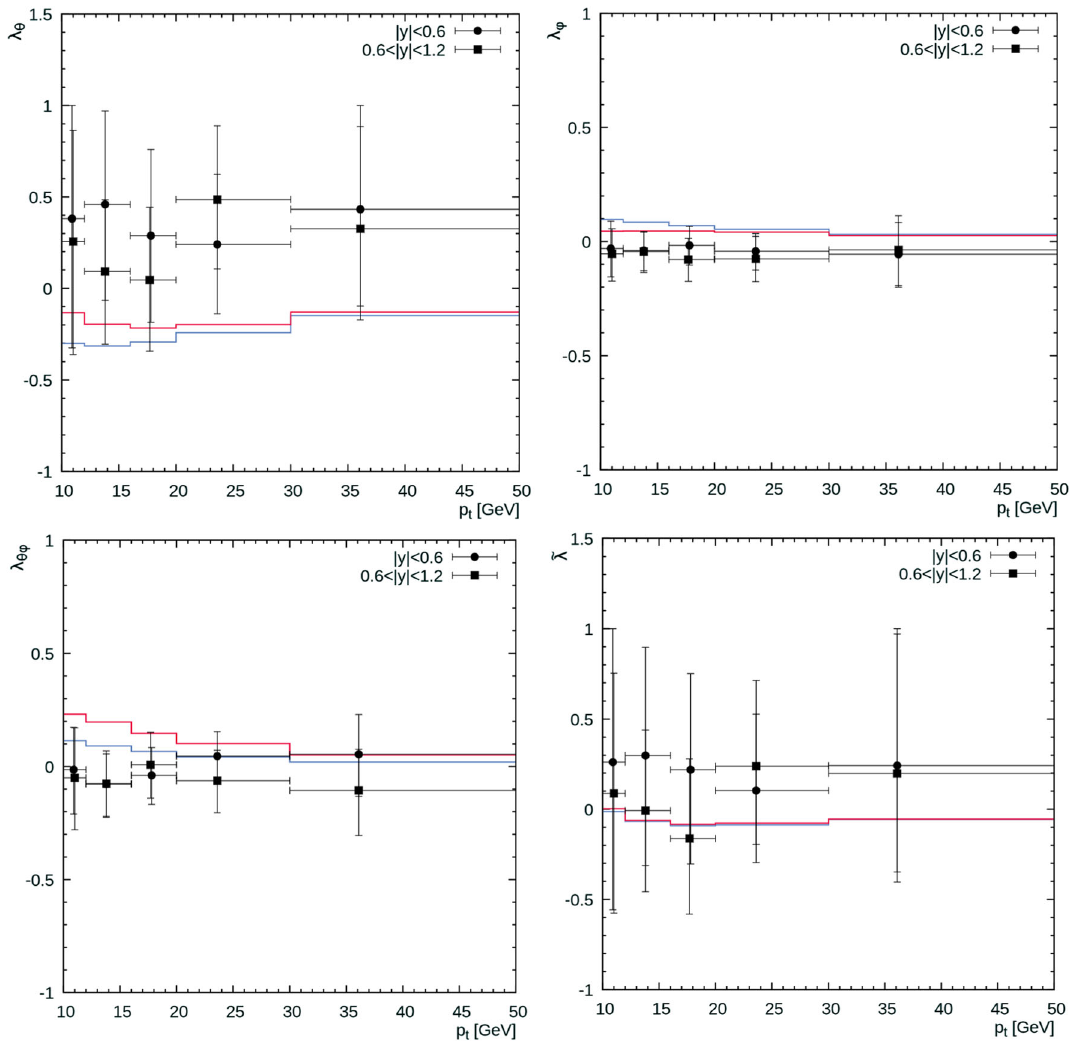
Fig. 7 The polarization parameters λ θ , λ φ , λ θφ and ˜ λ of ϒ( 2 S ) mesons calculated in the helicity frame as function of its transverse momentum √ s = 7 TeV. Notation of all histograms is the same as in Fig. 6. The experimental data are from CMS at